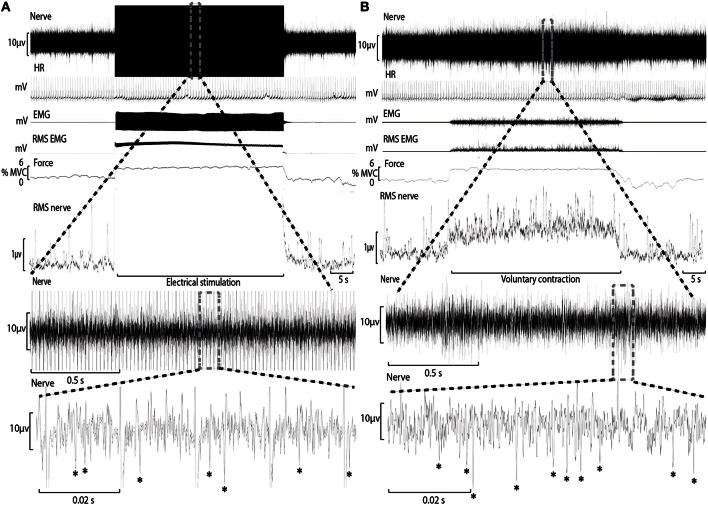
Experimental records from one subject during electrical stimulation of tibialis anterior (A) and during a weak voluntary contraction at a matched intensity (B). A section of the “Nerve” channel during electrical stimulation has been expanded to reveal the raw neural signal between electrical artifact and sympathetic spikes have been identified with an asterisk (*). The “Nerve” channel during voluntary contraction has also been expanded for comparison.